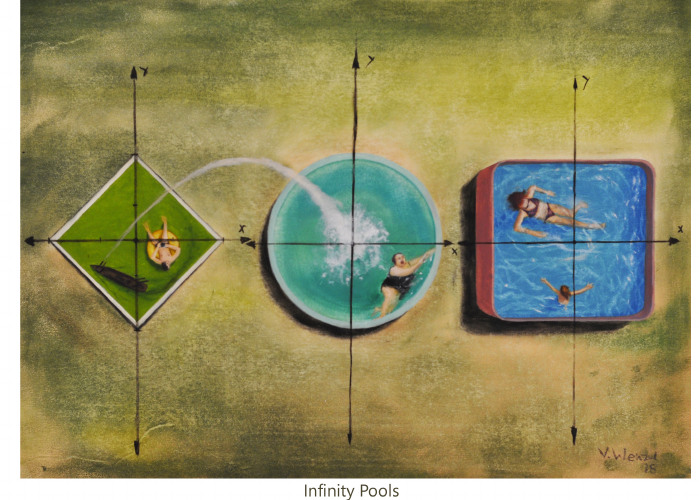
Figure 2. Unit circles with p = 1,2 and a big positive number from left to right ( Infinity pools , Oil on paper, 30 ×